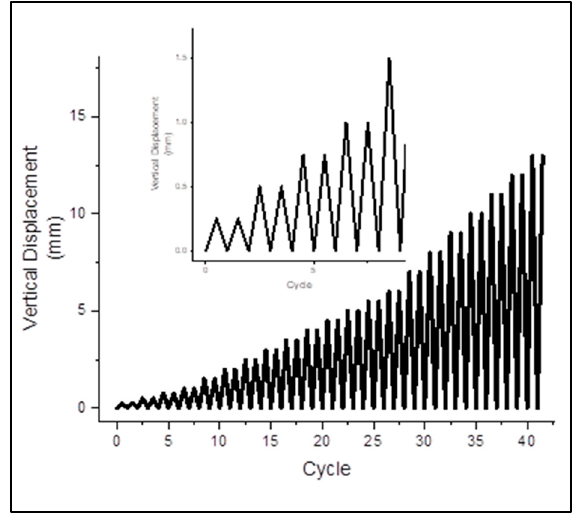
Figure 7. Loading